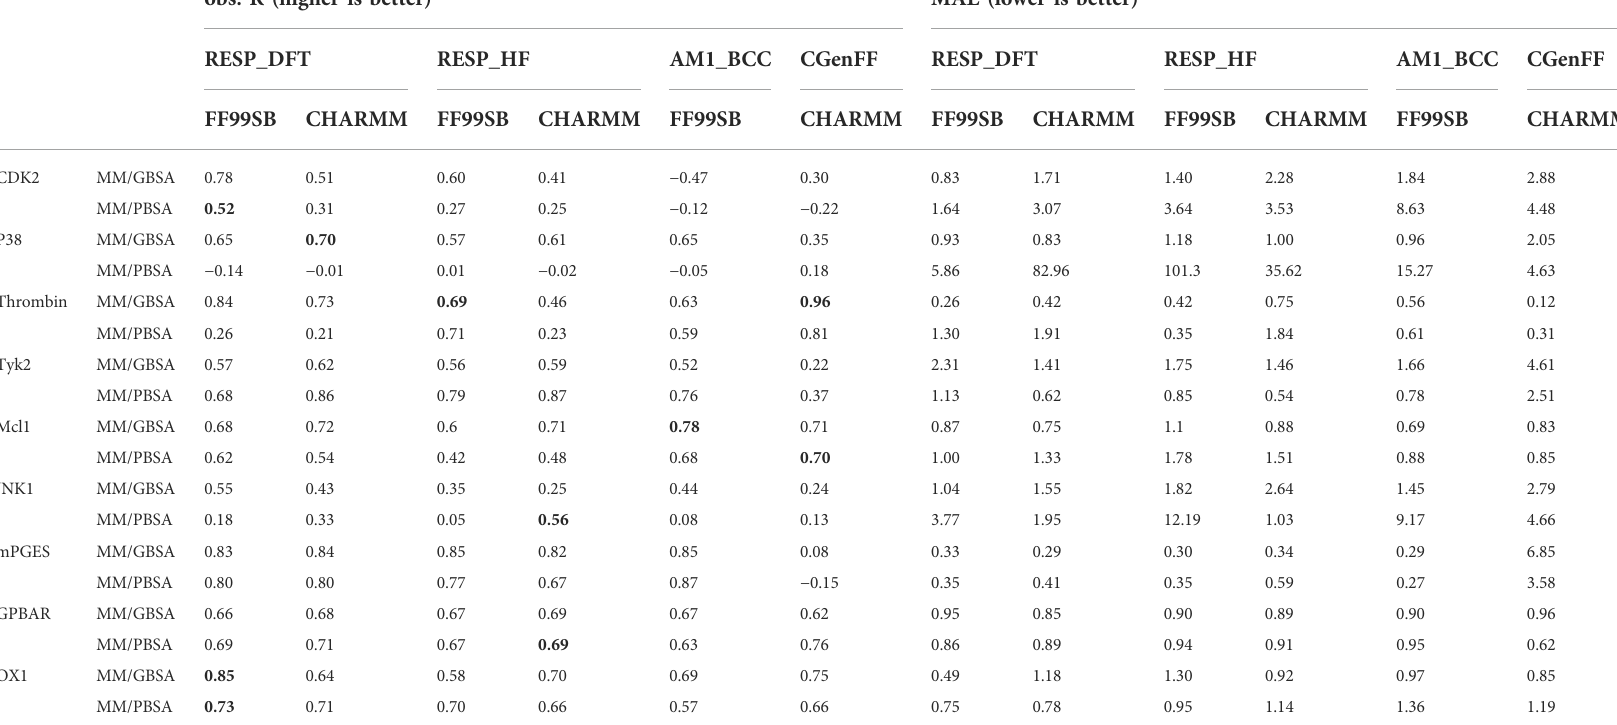
TABLE 1 The Pearson correlation coef fi cient (R) and mean absolute error (MAE) between MM/PB(GB)SA-predicted binding free energies and experimental data based on different ligand charge methods and protein force fi elds. obs. R (higher is better) MAE (lower is